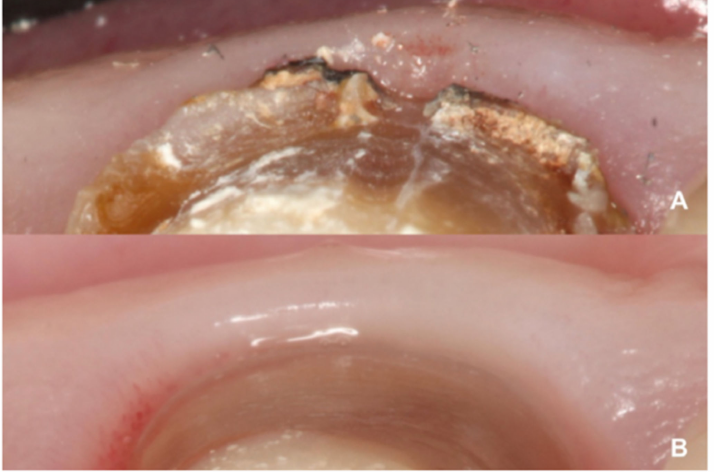
Figure 11. Differences in gingival thickness. ( A ) Tissue thickness adjacent to the horizontal finish line. ( B ) Tissue thickness adjacent to the